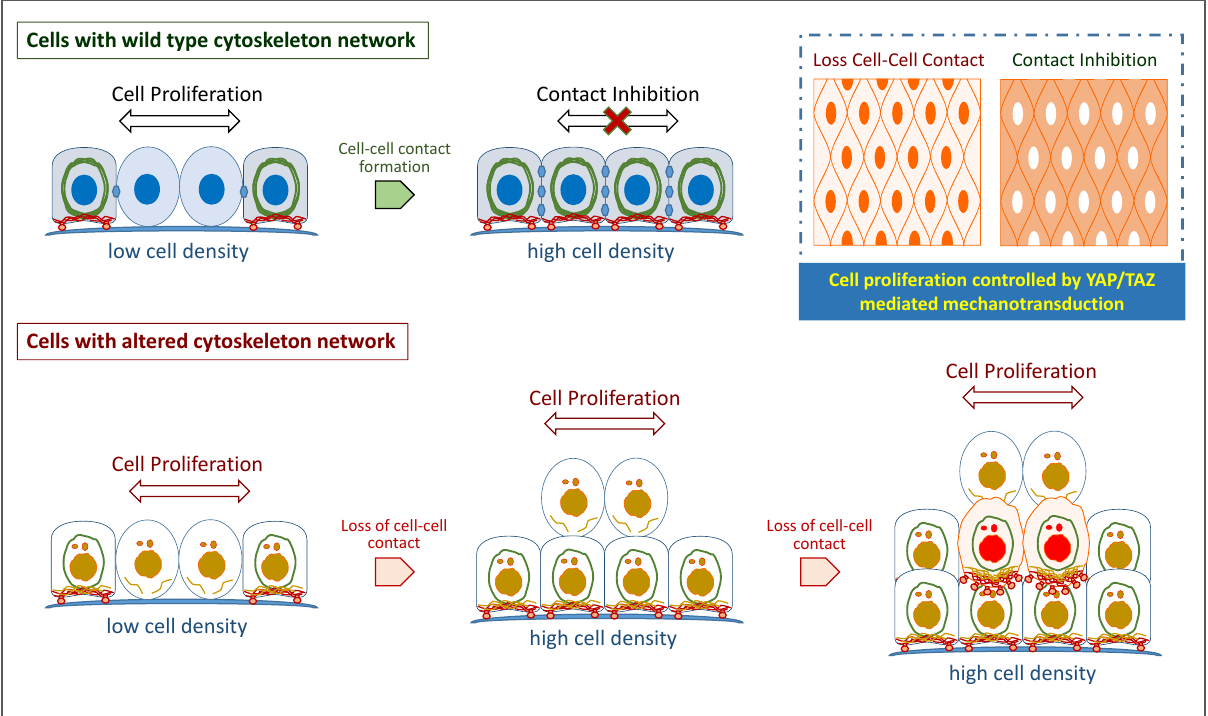
Figure 1. Cell softening and cancer stemness triggered by altered cytoskeleton networks. Cells with wild-type cytoskeleton networks maintain a mechanical structure in a symmetrical organization. When cells are at low cell density, Yap1 can be translocated into the nucleus and trigger cell proliferation. Once cells reach a high cell density with complete cell – cell contacts, the Hippo signaling is activated, and then subsequently suppresses Yap1 nuclear translocation and cell proliferation. Mutations in genes for cytoskeletal and its associated proteins disturb cytoskeleton networks, resulting in the failure of cell – cell contact formation. Thus, the cells cannot sense the contact inhibition signaling and keep proliferating continuously. Without mechanical support, cells tend to become softer and grow in multiple layers. Long-term effects of Yap1-mediated carcinogenesis will trigger cancer stemness and aggressiveness.